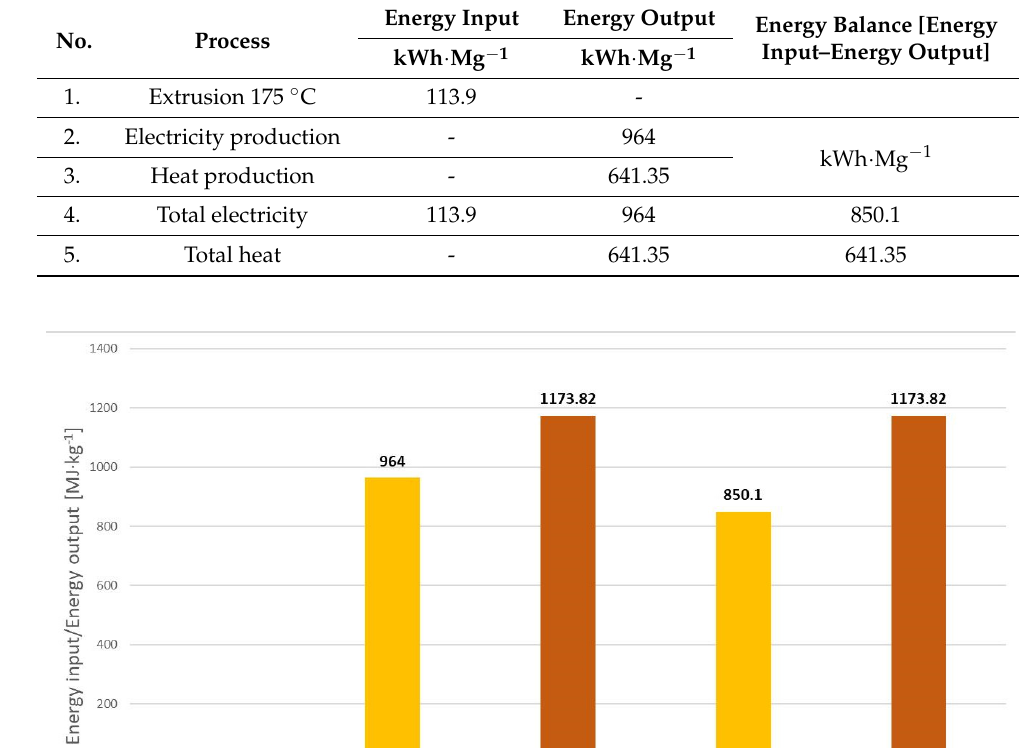
Figure 11. The heat of combustion and calorific value of Silphium perfoliatum L. at a moisture con- tent of